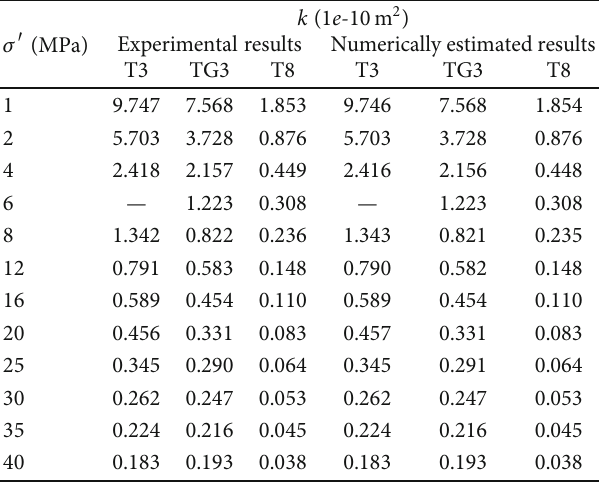
Table 4: Intrinsic permeability calculated from experiments and numerical simulation under loading stress.